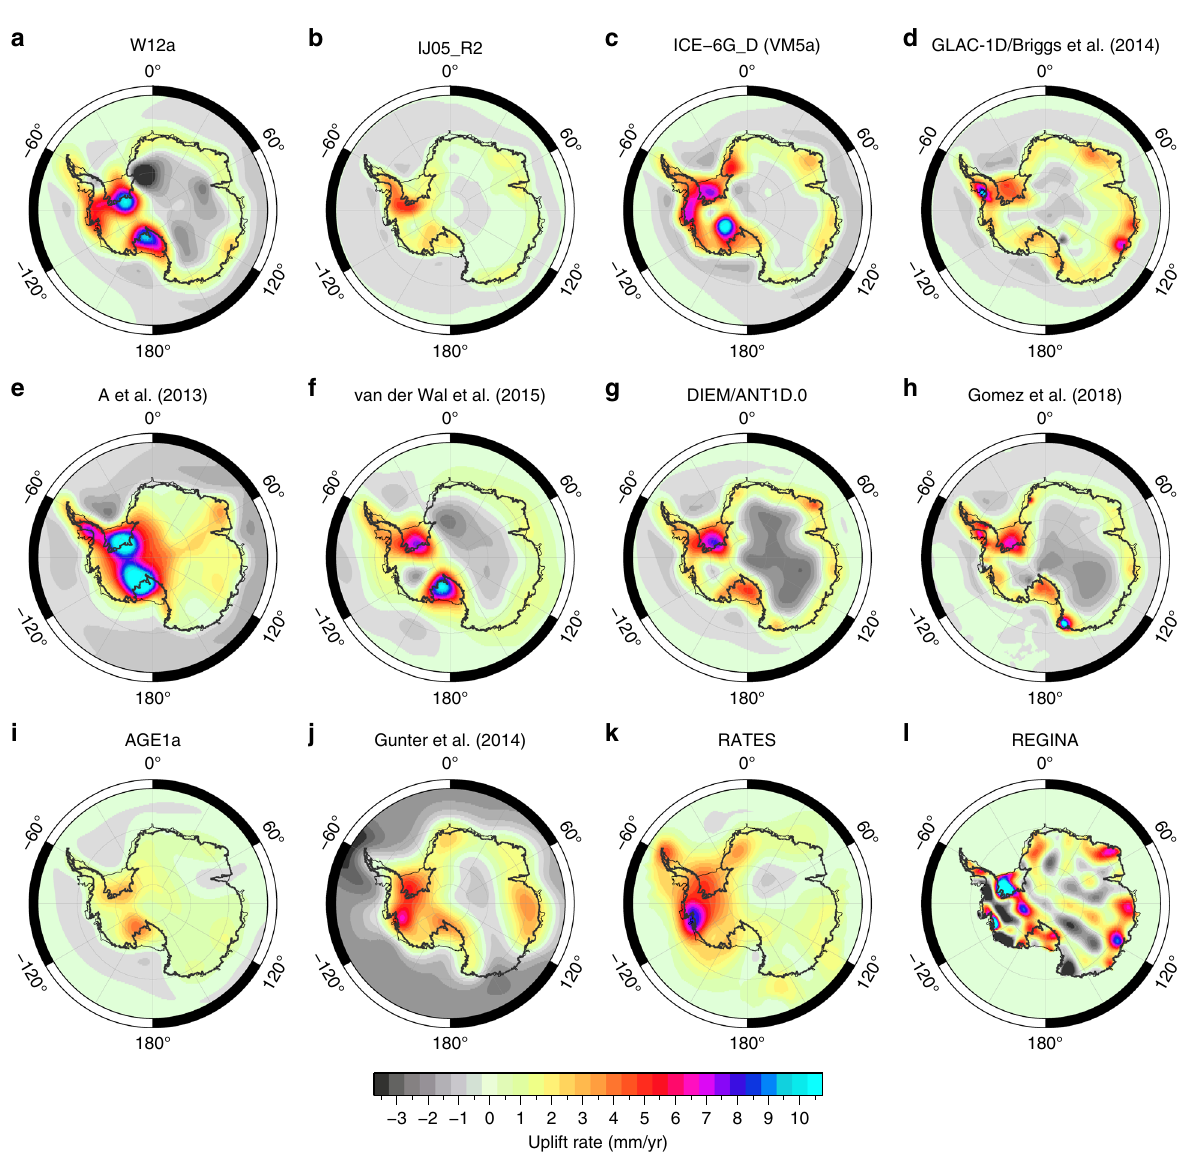
Fig. 2 Predictions of present-day GIA-related uplift rates across Antarctica derived from forward modelling and data inversion. a – d Results derived using GIA forward models that adopt a 1-D Earth model 17,18,30,32,141,145 ; in b an Earth model that re fl ects low viscosity West Antarctic mantle rheology is used. e , f Results derived using GIA forward models that adopt a 3-D Earth model 55,56 ; ( e ) uses the same ice model as c ; ( f ) uses the same ice model as a . g , h Results derived using coupled ice sheet – sea level models that include ice-sheet change through to present 10,87 . i – l Results derived from the inversion of geodetic data 42 – 44,146 ; note that i – l are reduced in their precision away from data constraints. See original publications for further details